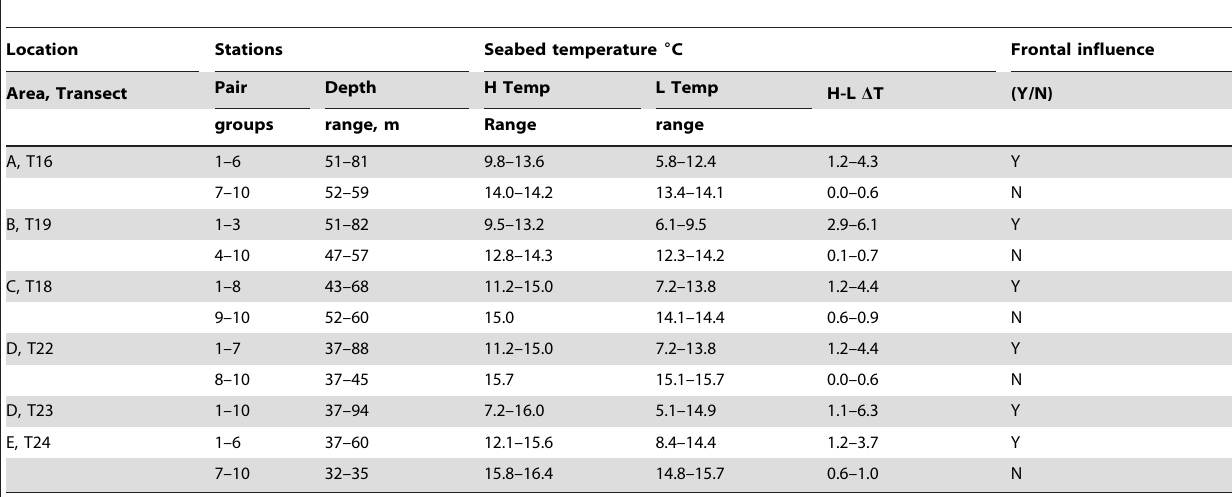
Table 1. Water depth, seabed temperature, and temperature change along transects across the tidal front.